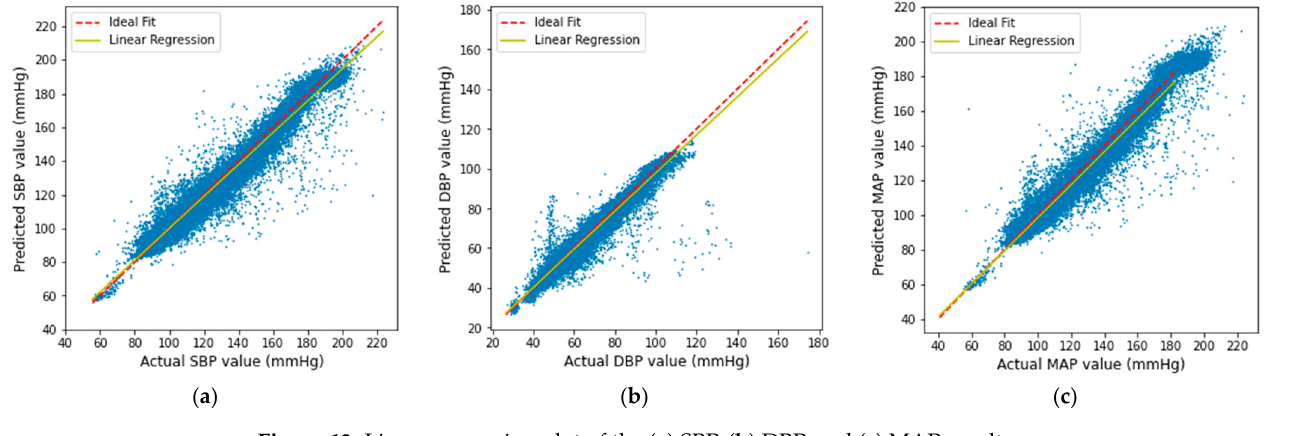
Figure 13. Linear regression plot of the ( a ) SBP, ( b ) DBP, and ( c ) MAP result. The Bland-Altman plots for the proposed algorithm are displayed in Figure 14 maintaining the AAMI criteria [43]. The x-axes represent pressure from 80 to 190 mmHg for SBP and 30 to 140 mmHg for DBP. The y-axes denote errors in the range of − 30 to +30 mmHg. Reference horizontal dotted lines are shown at the interval of 5 mmHg from − 15 to +15 mmHg. The mean of each actual BP and its relative predicted BP is plotted across their difference with a point. Greater than 30 mmHg differences are plotted at 30 mmHg and less than − 30 mmHg are plo tt ed at − 30 mmHg. It is observed that most of the SBP and DBP errors lie between − 5 to 5 mmHg in both cases.